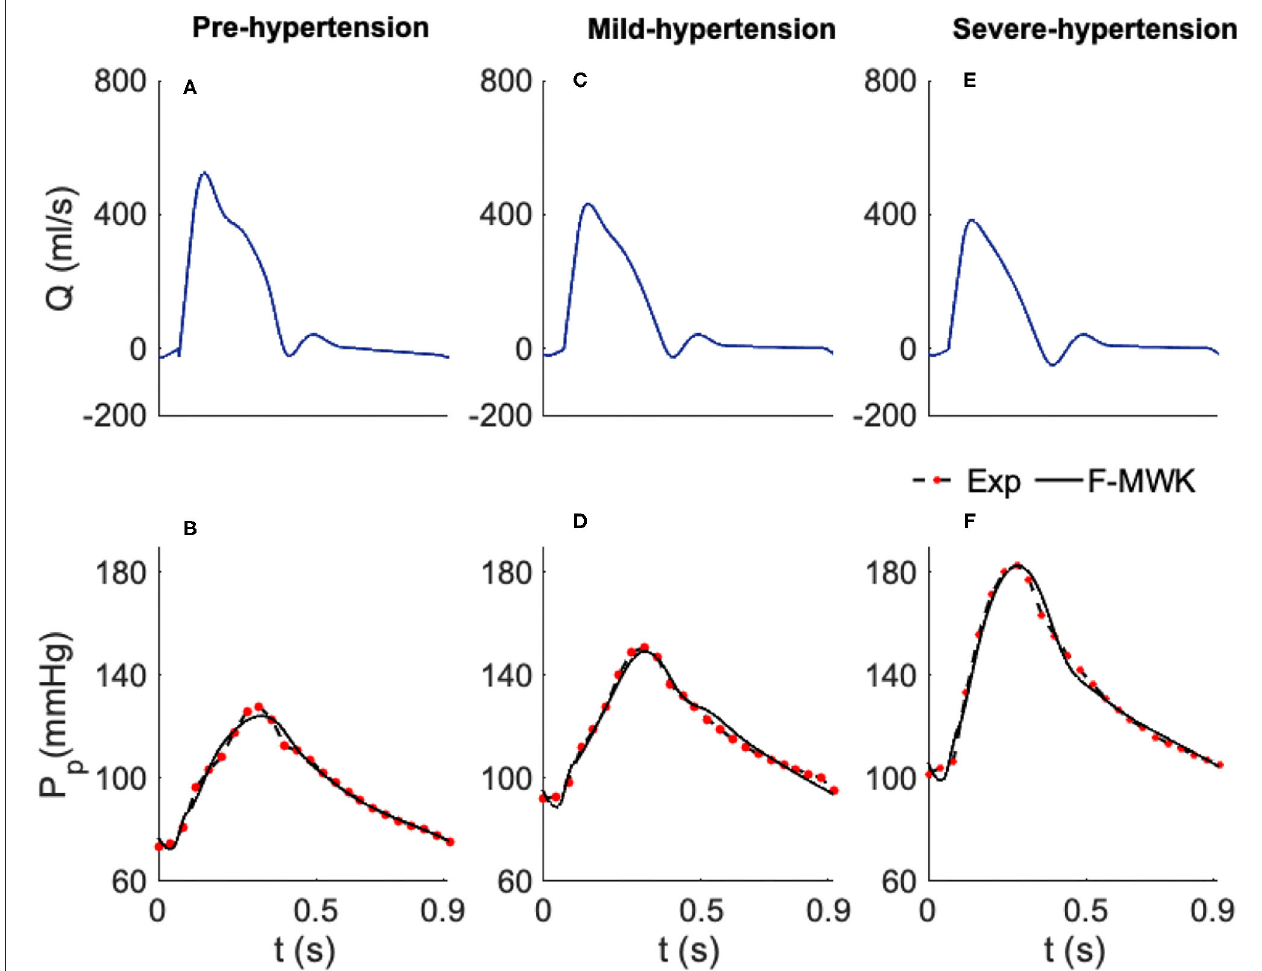
FIGURE 2 | Estimated proximal blood pressure using the proposed fractional-order modified Windkessel model along with the experimental in-vivo human-hypertension. (A,C,E) Represent the model input aortic-valve blood flow rate for each validation case of study, Pre-hypertension, Mild-hypertension, and Sever-hypertension, respectively. (B,D,F) Represent the pressure waveform validation